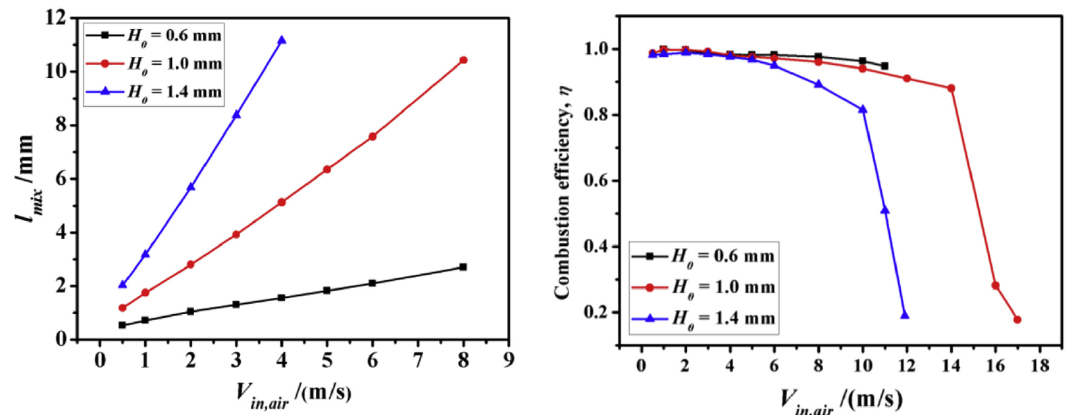
Figure 16. Numerical investigation on mixing performance and diffusion combustion characteristics of H 2 and air in planar micro-combustor by Li et al. [7]. ( Left ): Required mixing distance versus inlet air velocity for micro-combustors with different heights; ( Right ): Variations in combustion efficiency versus inlet air velocity in three micro-combustors with different